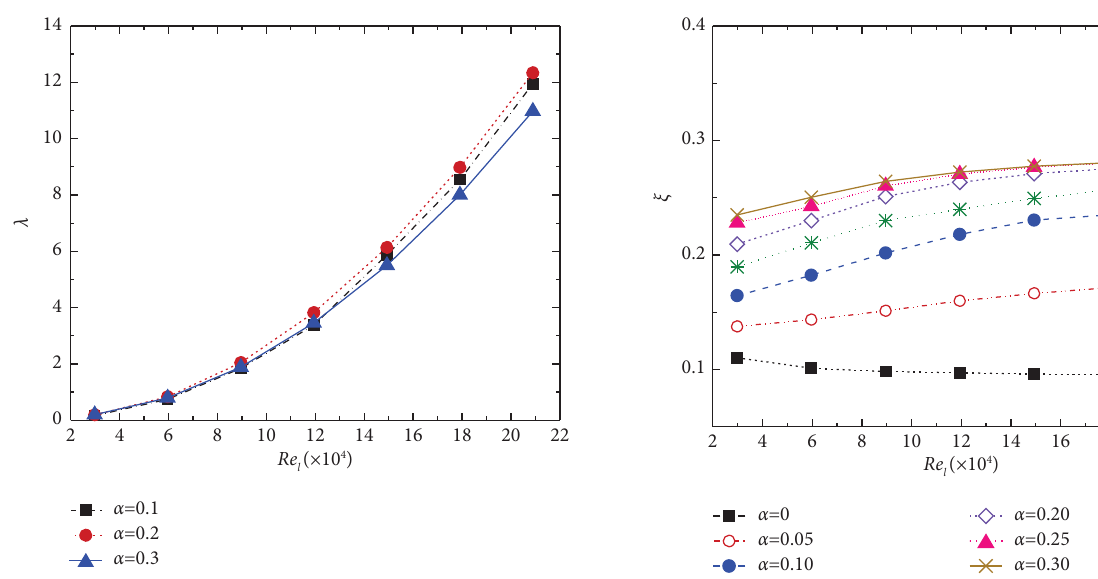
l under diferent α in